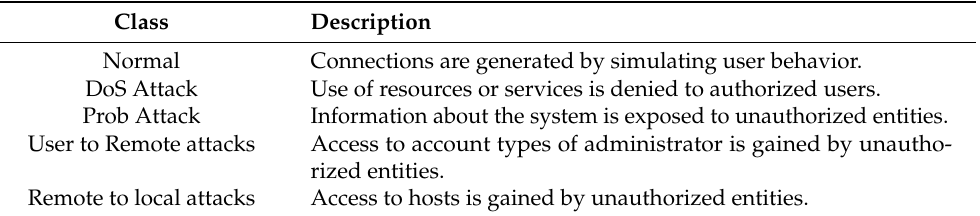
Table 3. Detail of classes in the dataset.